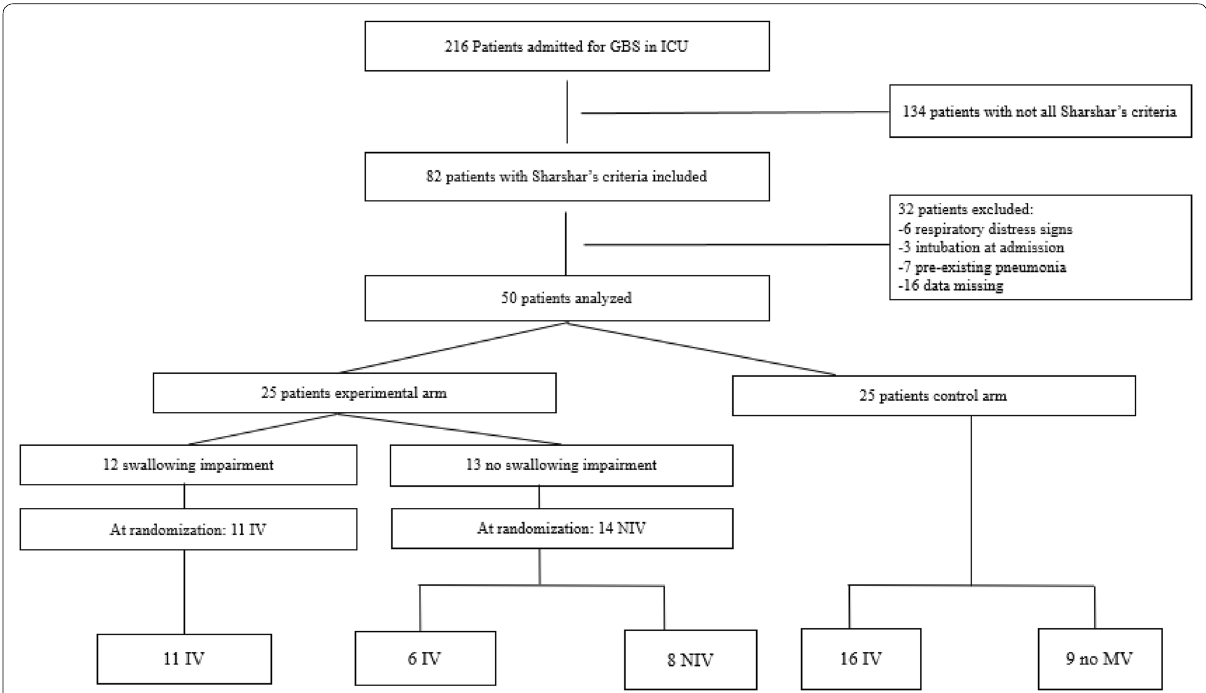
Fig. 1 Flowchart. IV: invasive ventilation; NIV: non‑invasive ventilation; no MV: no mechanical